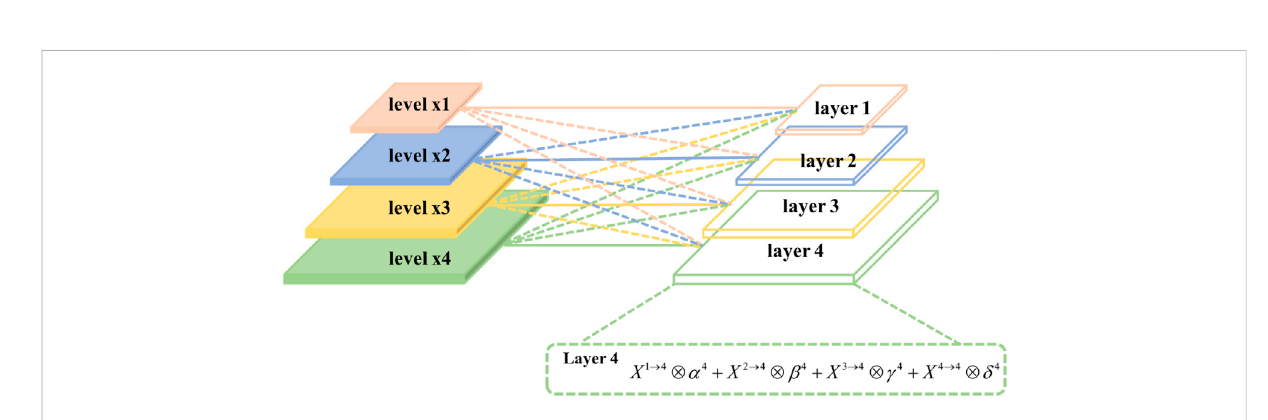
FIGURE 3 The structure of improved